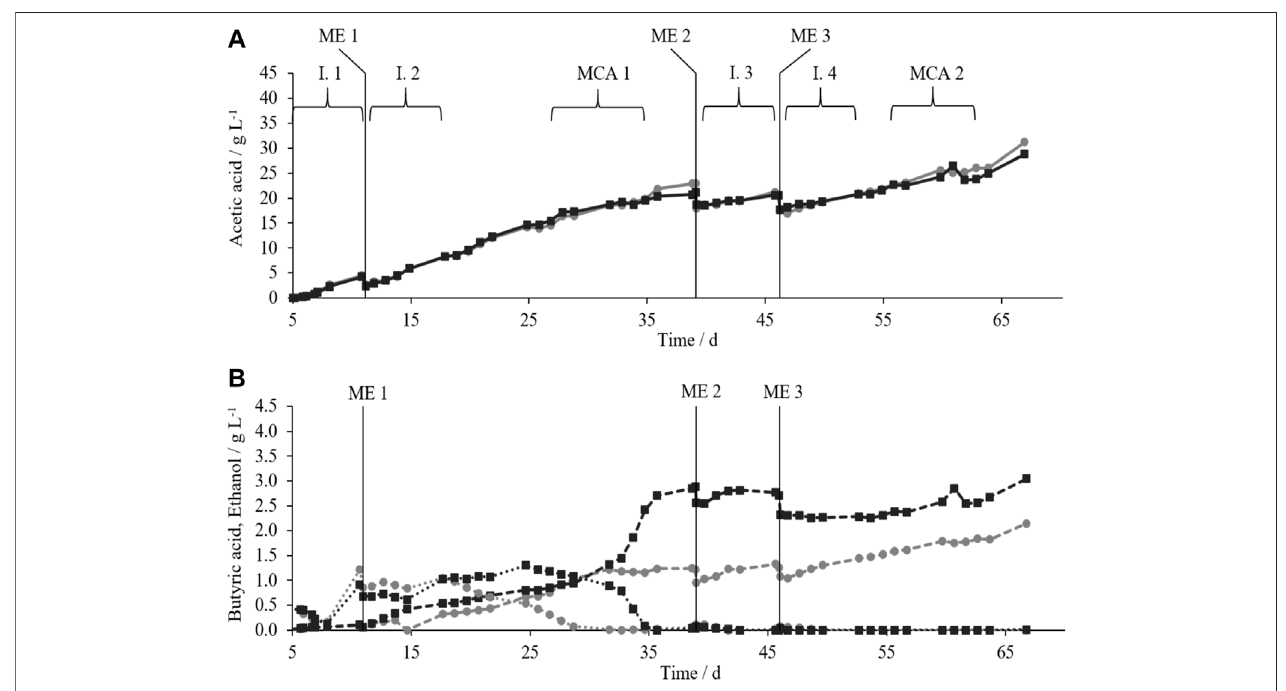
FIGURE 2 | (A) AAC (solid lines) and (B) BAC (dashed lines) and ethanol concentration (dotted lines) during acetic acid production in TB1 (grey circles) and TB2 (black squares) with MEs 1 – 3 (vertical lines); time intervals (I.) for calculation of AAPR after MEs; time intervals for microbial composition analysis